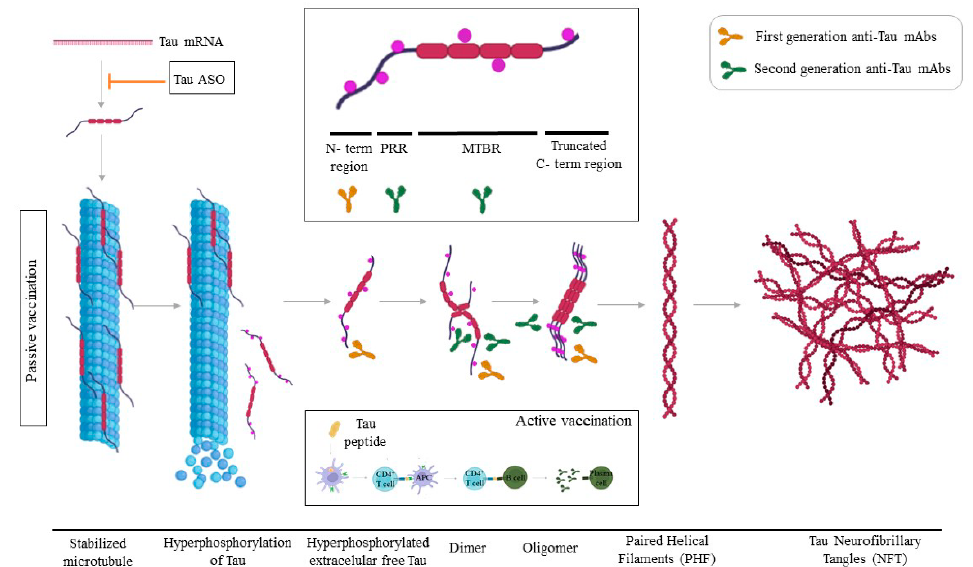
Figure 2. Anti-Tau strategies for the development of DMT. Passive immunotherapy is the main strategy under evaluation for reducing the cell-to-cell spread of extracellular Tau. At this moment specific phosphor-Tau mAbs are under clinical development. Other strategies such as active vaccination and antisense oligonucleotides to reduce Tau levels are also under evaluation in clinical trials.